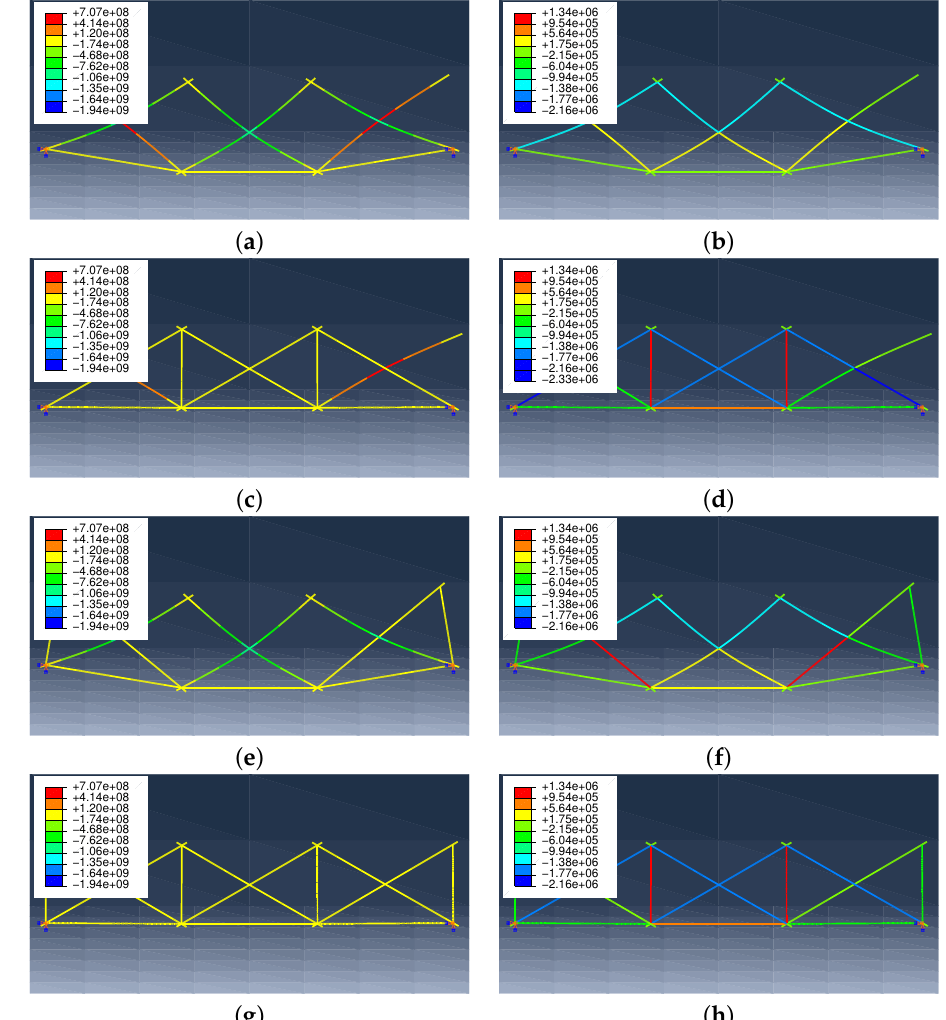
Figure 13. Numerical results in lower decks pattern (response magnification 100 times): ( a ) BMD in Case 1-1; ( b ) AFD in Case 1-1; ( c ) BMD in Case 1-2; ( d ) AFD in Case 1-2; ( e ) BMD in Case 1-3; ( f ) AFD in Case 1-3; ( g ) BMD in Case 1-4; ( h ) AFD in Case